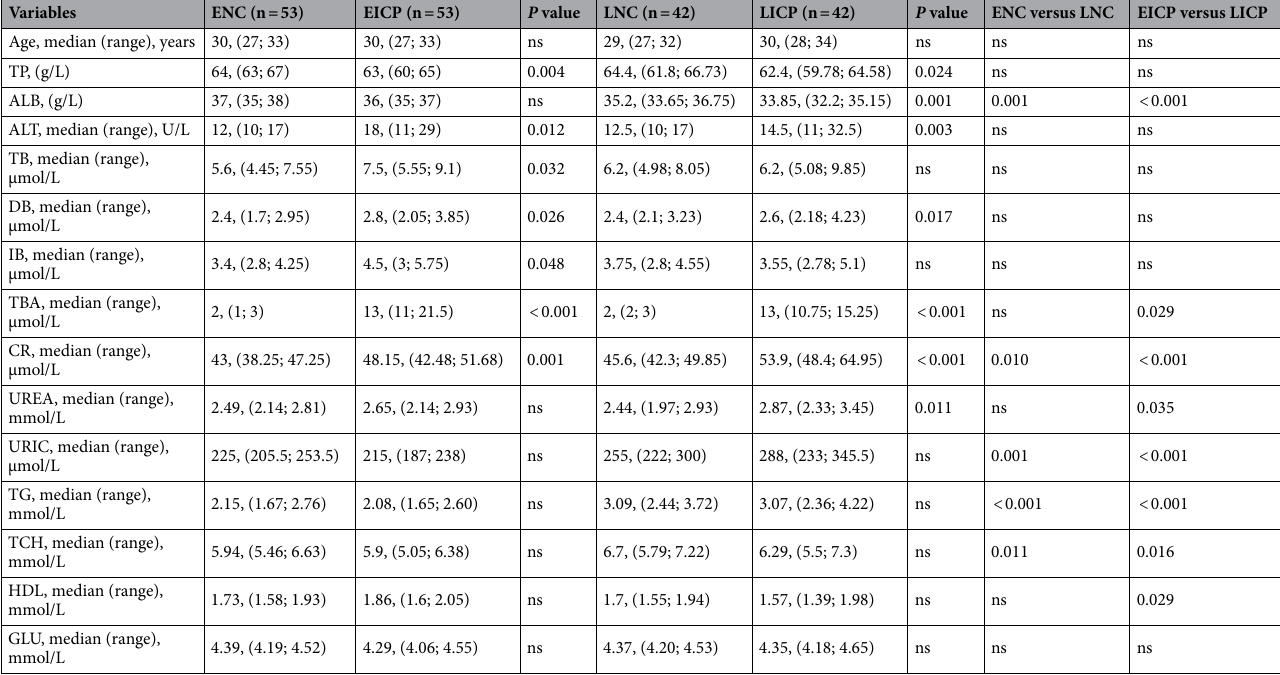
Table 2. Characteristics of enrolled normal pregnant women and patients with ICP grouped by gestational